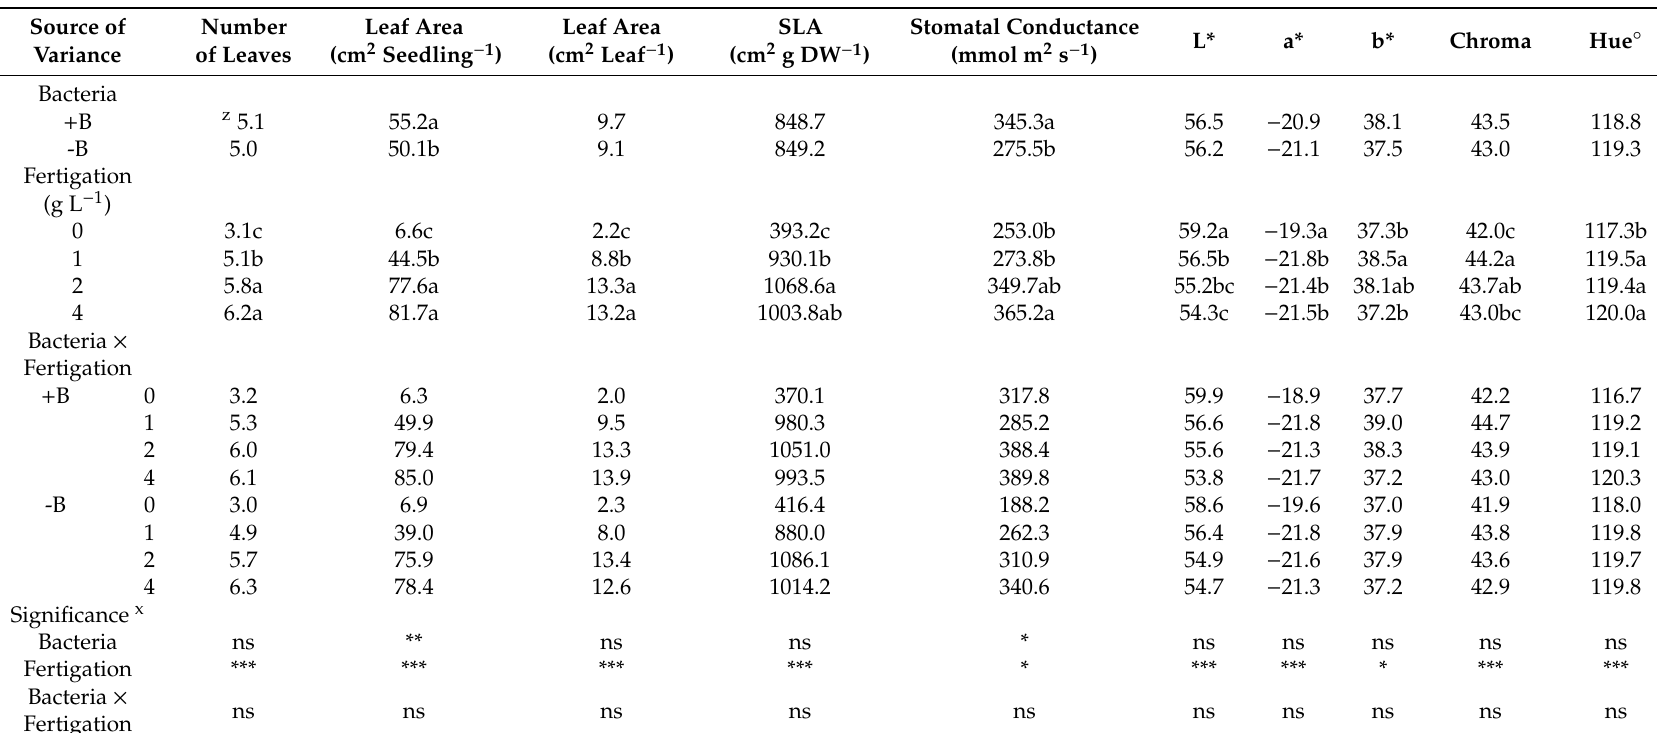
Table 2. E ff ects of the bacterial biostimulant (-B, not inoculated; + B, inoculated) and fertigation rate (g L − 1 of NPK 20-20-20) on leaf characteristics of lettuce seedlings. Source of